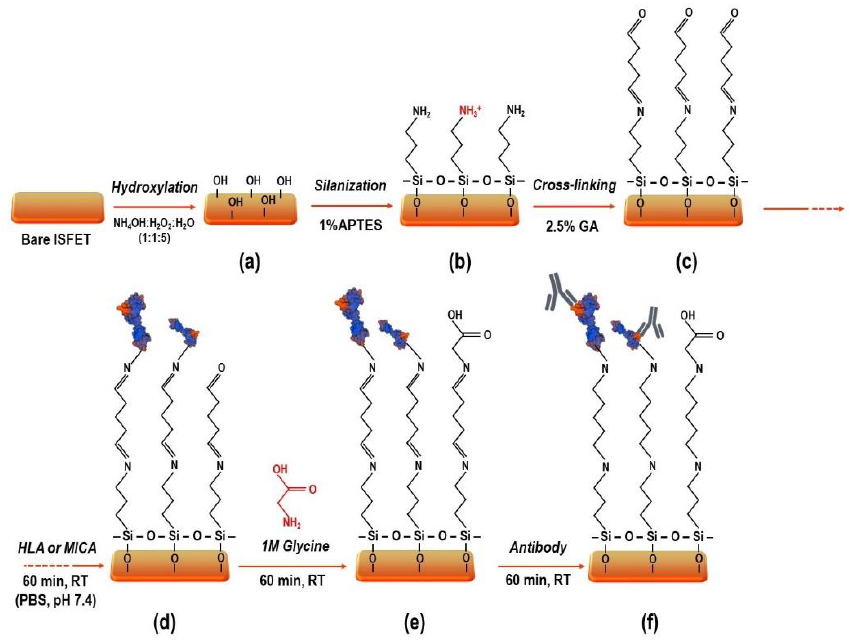
Figure 10. The schematic illustrates the processes for surface modification, protein immobilization, and antibody detection. ( a ) The Si 3 N 4 substrates’ cleaning using RCA-1 solution; ( b ) the development of silane layer using 1% APTES; ( c ) the formation of covalent bonding using 2.5% GA; ( d ) the immobilization of proteins; ( e ) the blocking of unspecific binding sites using 1M Glycine; ( f ) the binding of antibodies .